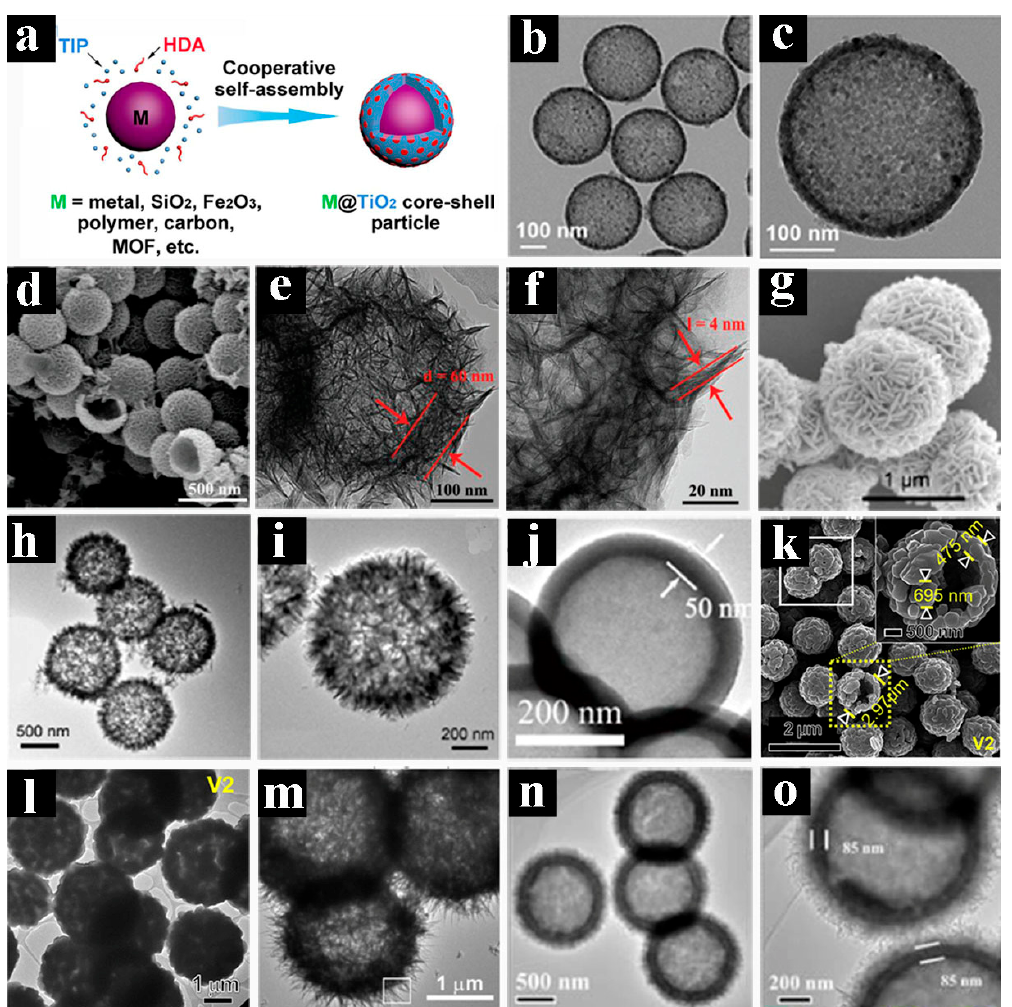
Figure 1. Schematic demonstration and graphical illustration of hollow spheres: ( a ) Schematic illustration of the formation process of mesostructured titanium dioxide (TiO 2 ) shells, ( b ) transmission electron microscopy (TEM) image of TiO 2 hollow nanospheres, and ( c ) magnified TEM image shows an individual TiO 2 hollow nanosphere. ( d ) scanning electron microscopy (SEM) image and ( e , f ) high-magnification TEM images of the NiCo 2 S 4 hollow spheres. ( g ) SEM, and ( h , i ) TEM images of the α -Fe 2 O 3 hollow spheres. ( j ) TEM image of the HM-Nb 2 O 5 nanospheres. ( k ) SEM image and ( l ) TEM image of V 2 O 5 hollow microspheres. ( m ) TEM image of the NiCo 2 O 4 hollow microspheres. ( n , o ) TEM images of V 2 O 3 @C hollow spheres. Pictures ( a ), ( b ), and ( c ) were reprinted with permission from Reference [73]. Copyright Science, 2018. Pictures ( d ), ( e ), and ( f ) were reprinted with permission from Reference [74]. Copyright Wiley, 2018. Pictures ( g ), ( h ), and ( i ) were reprinted with